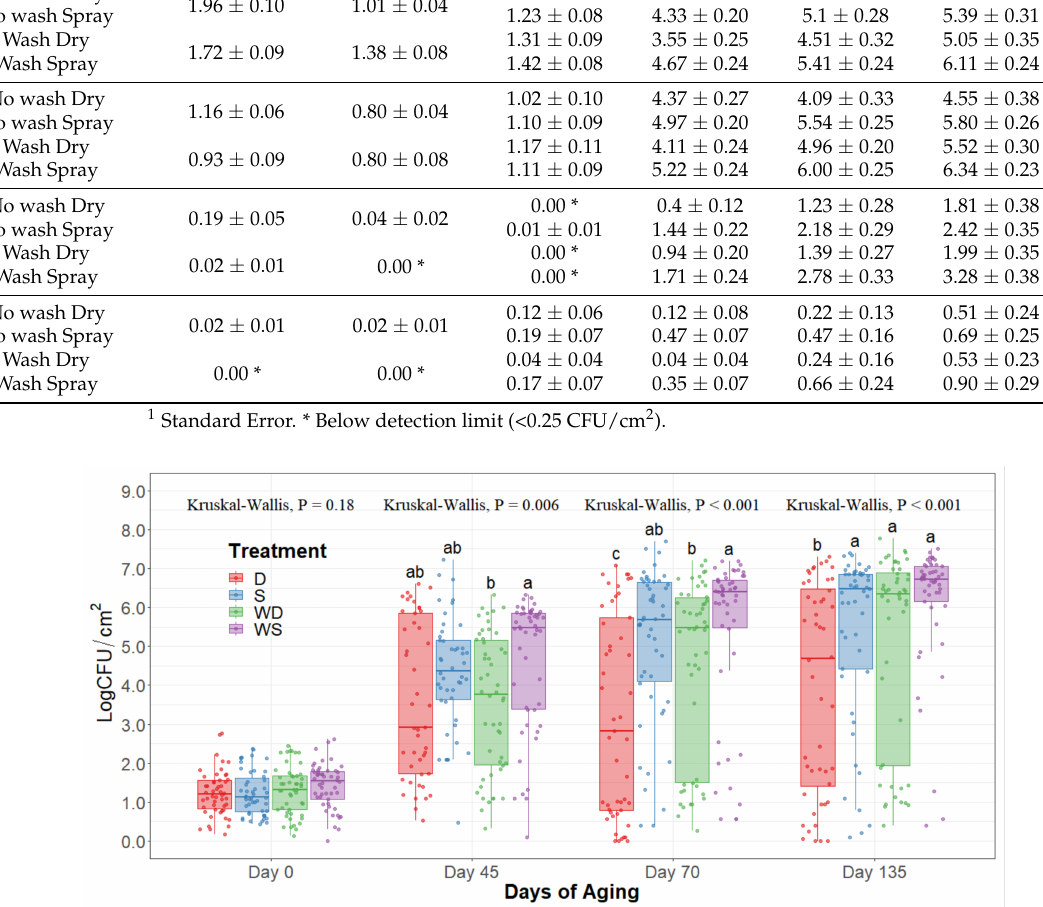
Figure 3. Aerobic plate counts of striploins at day 0, 45, 70, and 135 of refrigerated storage. The horizontal line within the box plot represents the median. The box upper and lower limits represent the interquartile range, and the bars represent the 1.5xInterquartile Range. D = No Wash Dry chill, S = No Wash Spray chill, WD = Wash Dry chill, WS = Wash Spray chill. a–c Box plots with different letters within each sampling date are significantly different ( p <